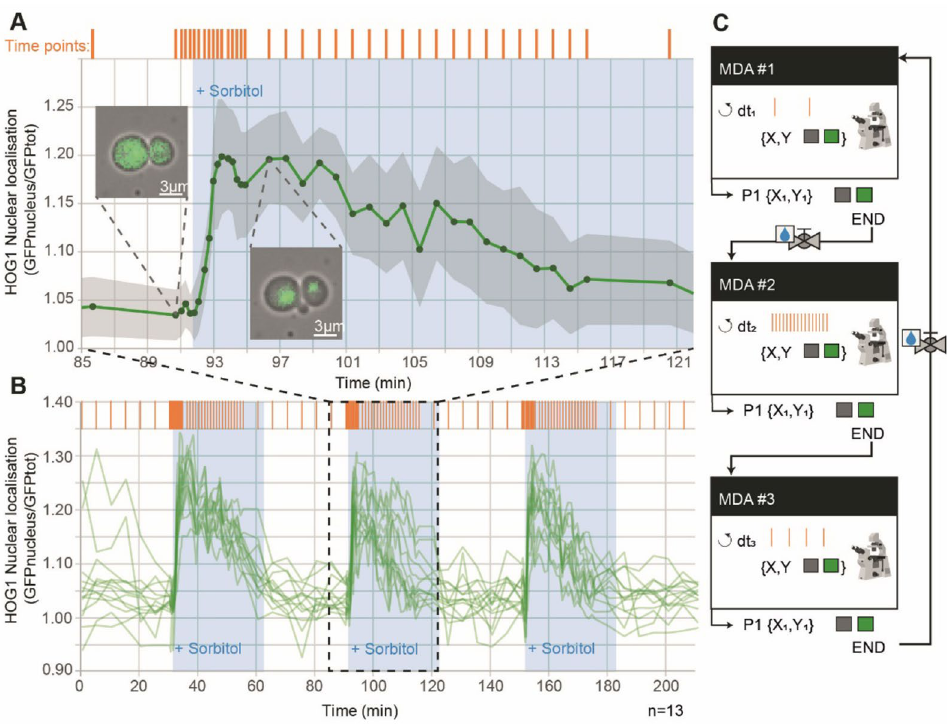
Figure 3. Synchronization of the acquisition framerate with dynamic perturbations to capture yeast cell signaling dynamics. ( A ) Time course of nuclear accumulation of Hog1p in yeast cells growing as a monolayer in a microfluidic chamber subjected to an osmotic stress (1 M sorbitol). The insets show localization of Hog1-GFP before and after the osmotic stress. The acquisition framerate (orange bars) is automatically adjusted from one frame every 5 min to one frame every 25 s (12 times faster) just before the cells are stressed osmotically. The autofocus was turned off during the first 4 min of rapid Hog1 nuclear import. Recovery of the cells was then monitored at one frame every minute for 20 min, and finally the framerate was set back to its initial value (one frame every 5 min) until the next stress. The grey area represents the ± standard deviation of nuclear localization across 13 tracked cells from one microfluidic chamber. ( B ) The adaptive sampling rate used in ( A ) was repeated three times to demonstrate that cells exhibit reproducible dynamics in response to every stress. This experiment allowed the timescales of activation (fast) and deactivation (slow) of the HOG cascade to be measured in an unsupervised manner. ( C ) Sketch of the adaptive sampling MDA, which consists of three MDA experiments: one with a fast acquisition rate (nuclear import dynamics), one with a medium acquisition rate (nuclear export dynamics), and one with a slow acquisition rate (cell division after recovery). The switch from MDA#1 to MDA#2 is synchronized with the activation of an electrofluidic valve that delivers an osmotic stress of 30 min duration (repeated every 60 min). Nuclear localization is computed as the mean of GFP fluorescence in the nucleus normalized to the mean of GFP fluorescence in the entire